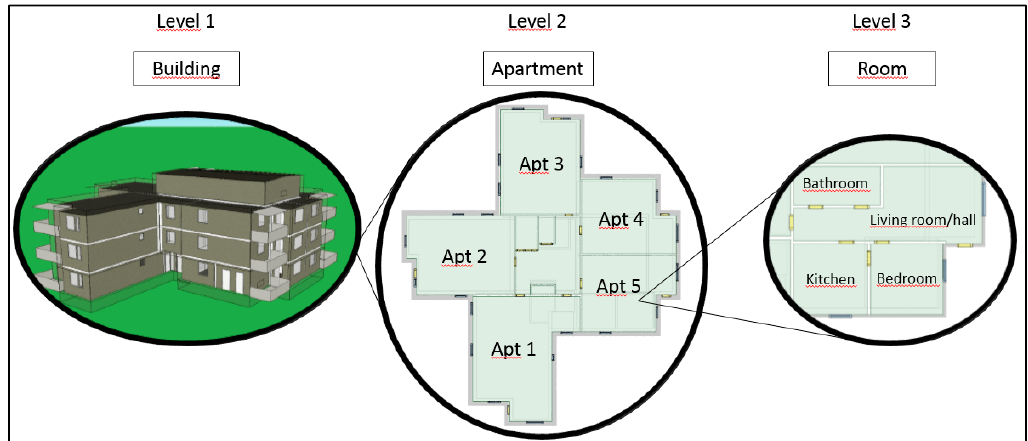
Figure 5. The three different levels on which simulated results between BES-ref and BES v.2 were Figure 5. compared.